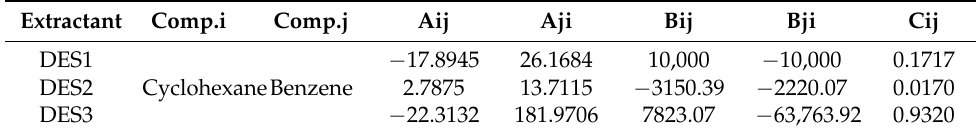
Table 4. The binary interaction parameters of NRTL model fitting with cyclohexane-benzene-DES system.